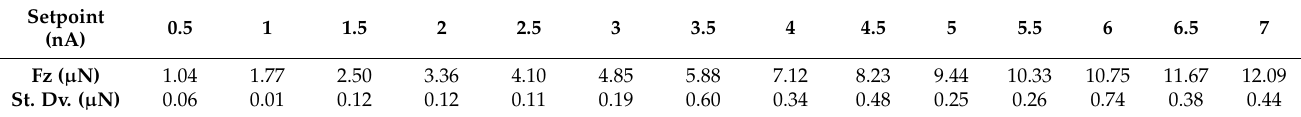
Table 1. Force values estimation by force